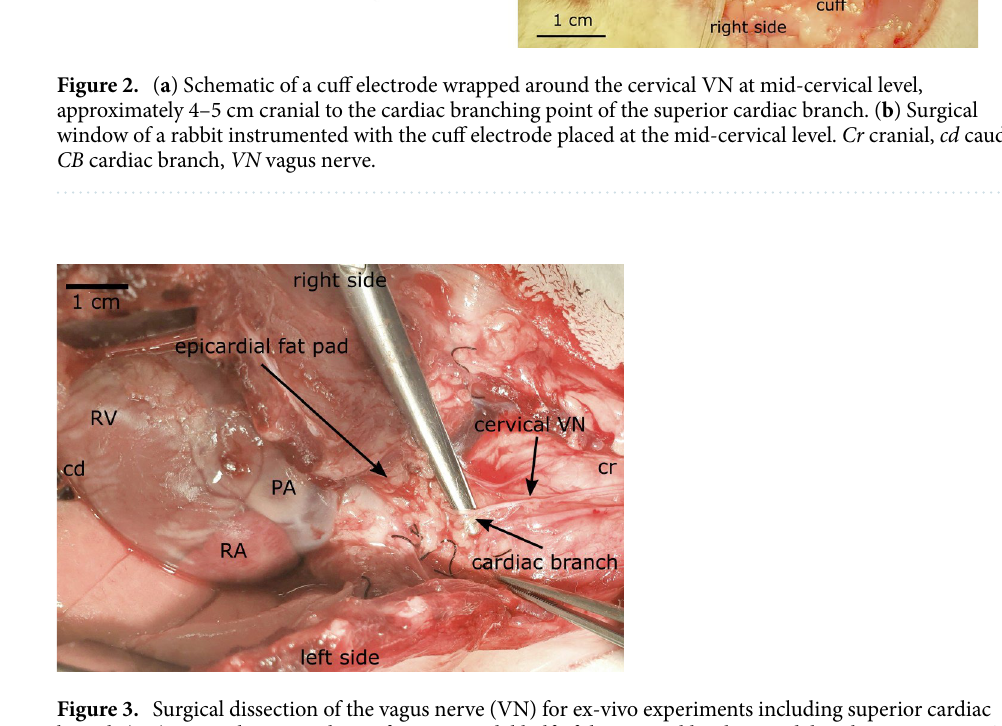
caudal until it dived into the epicardial fat pad as shown above in Fig. 3. Prior to excision of the heart, a bolus of heparin (1000 I.E./kg) was administered and the right VN was cut just above the nodose ganglion, followed by carefully separating the heart caudal from the thoracic arteries and cranial at level of the aortic arch. Care was taken to prevent the VN and the cardiac branch from mechanically rupture during surgery and heart excision. The heart was rapidly excised and immediately placed into ice-cold Krebs–Henseleit buffer. Ex‑vivo setup and instrumentation. Finally, the aorta was quickly cannulated, and the heart was mounted to the isolated heart system. Perfusion of the innervated isolated heart was performed under constant pressure (80 mmHg) in Langendorff mode with erythrocyte-enriched Krebs-Henseleit buffer in order to improve oxygena- tion of the cardiomyocytes. The nerve was kept moist throughout the experiment using isotonic sodium chloride (0.9%) to maintain vitality and excitability. Details on the setup of the isolated heart system and the chemical composition of the erythrocyte- enriched Krebs–Henseleit buffer are described in 32,33 . The right VN was instrumented ex-vivo using two concentric needle electrodes connected to a linear iso- lated stimulator (STMISOLA, BioPac Systems), same as used for in-vivo experiments, with the cathode placed approximately 2 to 5 mm cranial to the cardiac vagal branch (CB) and the anode placed 2–5 mm further cranial to the anode as shown in Fig.4a,b. The ex-vivo experiments were principally performed in preparation for heart rate control strategies using a trans-fascicular intraneural microelectrode (TIME) array. Therefore, intraneural stimulation for the cervical and cardiac vagus nerve was performed using a bipolar array of needle electrodes to mimic the stimulation using TIME electrodes. In order to acquire ECG, two wire electrodes (MyoStim ® Bipolar Bifurcate) were inserted into the right atrium (Fig. 4b). Same as for in-vivo, the ECG signals were pre-amplified with a gain of 1000 using a differential amplifier low-pass filtered at 1000 Hz, high-pass filtered at 1 Hz (Warner Electronics DP-304A). Same as in-vivo, a dSPACE MicroLabBox system and a custom-developed software were used for digitalization and recording of data. Assessing the chronotropic effects of VNS in‑vivo and ex‑vivo. In both setups, VNS was performed in synchronization with the cardiac cycle, where bursts of cathodic-anodic charge-balance rectangular stimu-